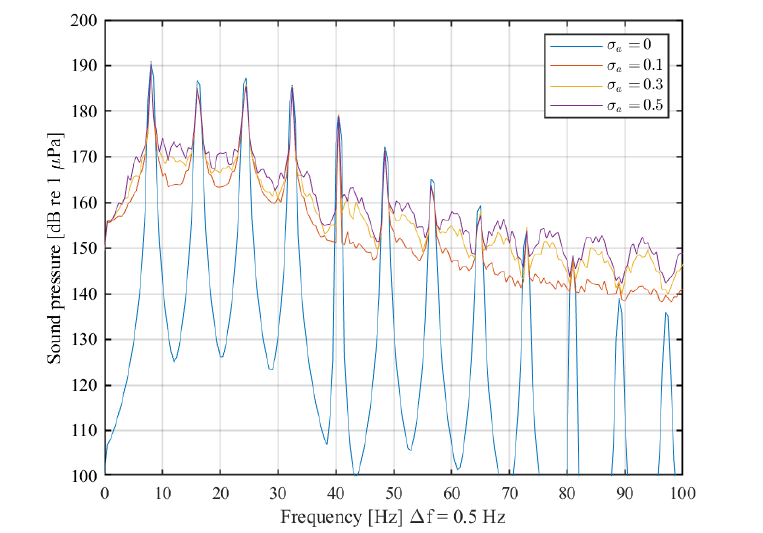
Figure 9. Sound pressure spectra of artificial signals generated by variation in the cavitation volume amplitude based on three different standard deviations σ a in comparison to the unvaried signal (blue line) for 96.5